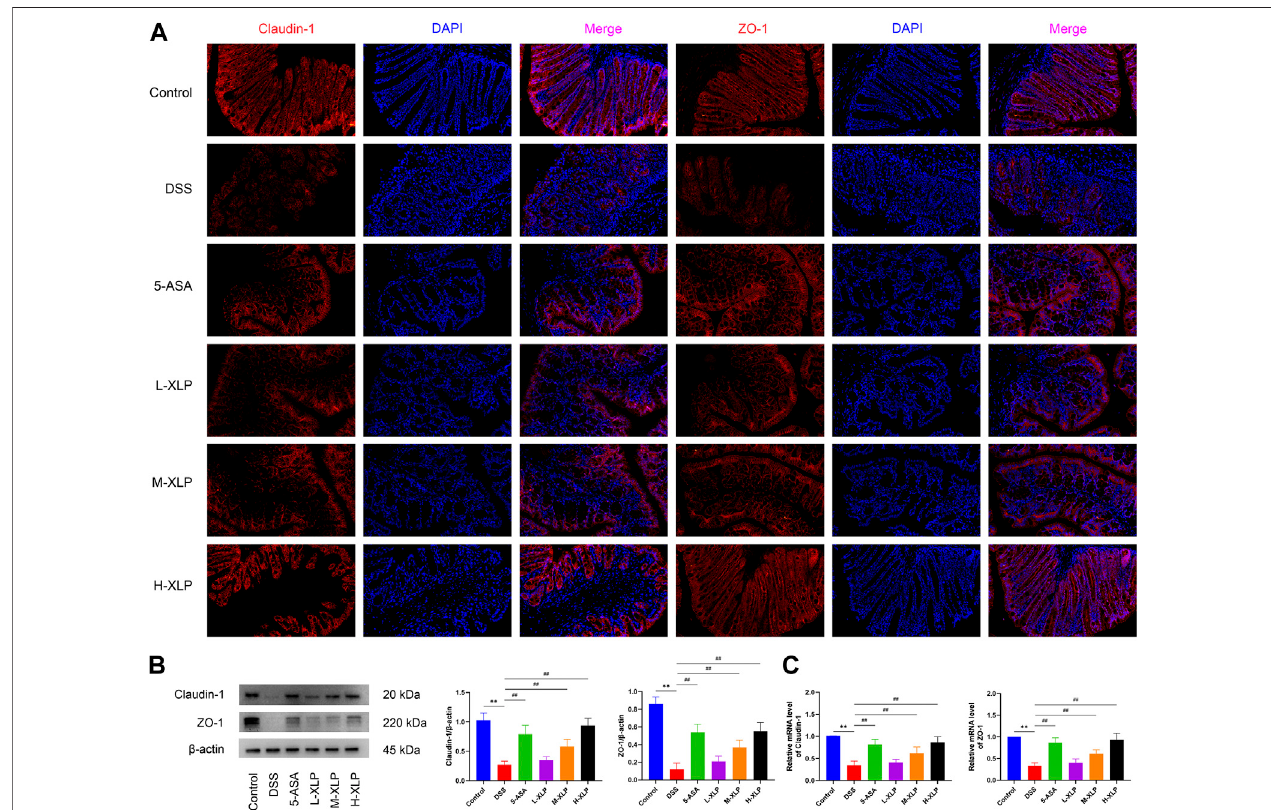
FIGURE 4 | Xianglian pill attenuated epithelial barrier function of DSS-induced colitis in mice. (A) Colon tissues were stained with claudin-1 or zonula occludens-1 (red)andnuclei-stainedwithDAPI(blue).Fluorescenceimageswerecapturedusinga fl uorescencemicroscope( × 200). (B) Expressionofclaudin-1orzonulaoccludens- 1 in colon tissues were detected by western blot and data were expressed as fold change in protein expression normalized to β -actin expression. (C) Expression of claudin-1 or zonula occludens-1 mRNA in colon tissues were detected by quantitative real-time PCR and data were expressed as relative mRNA expression normalized to GAPDH expression, with respect to the control group. * p < 0.05, ** p < 0.01 vs. control group, # p < 0.05, ## p < 0.01 vs. DSS